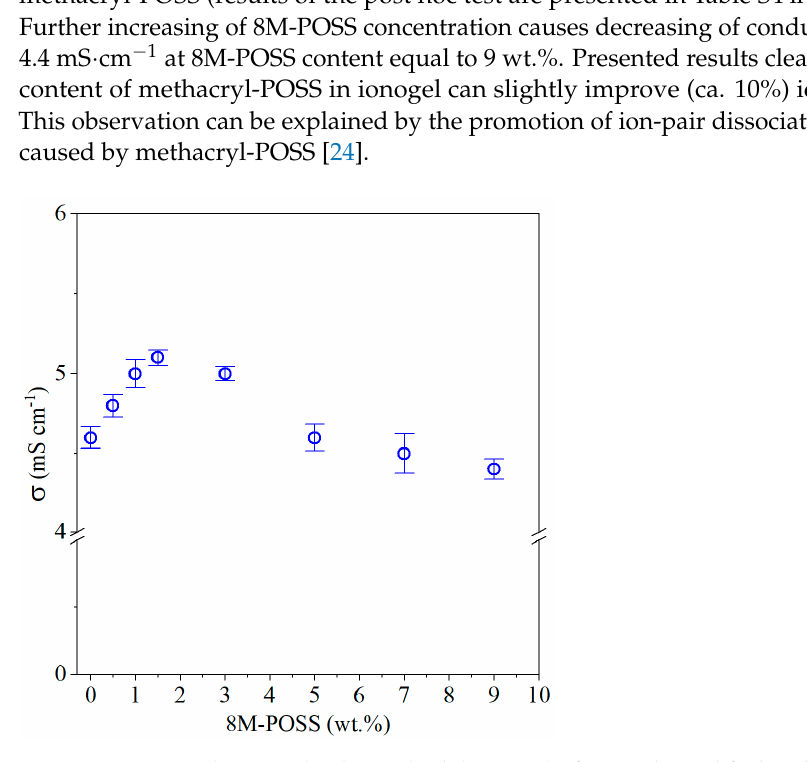
Figure 9. Ionic conductivity (with standard deviation) of ionogels modified with different amounts of methacryl-POSS.